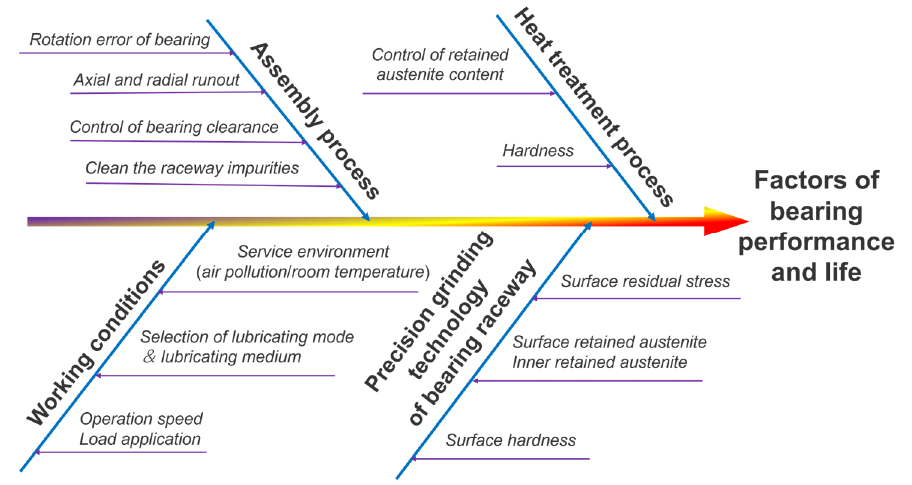
Figure 1. Ishikawa diagram of factors affecting bearings’ performance and life.